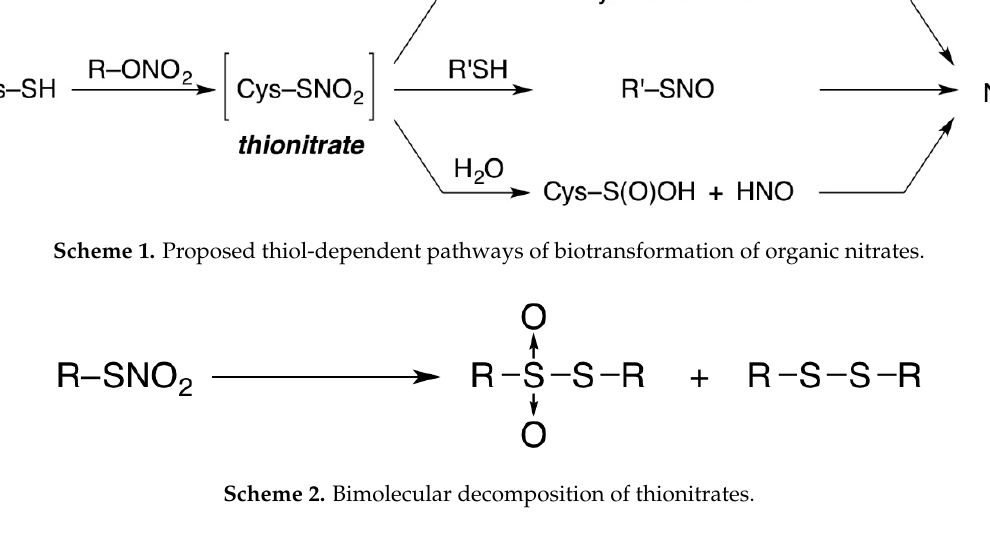
Figure 1. Molecular cavities utilized for the present model study.